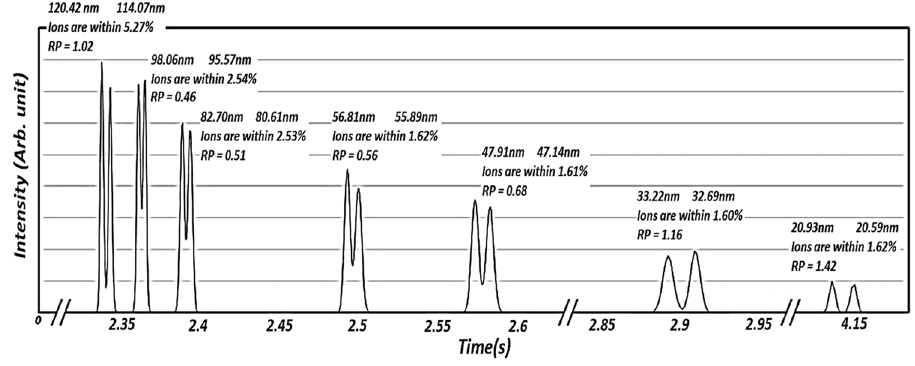
Figure 8. Separation of pairs of peaks using SIMION for two similar sizes. No optimization for resolution was attempted. Resolving power is used instead of resolution to specify whether or not two peaks are